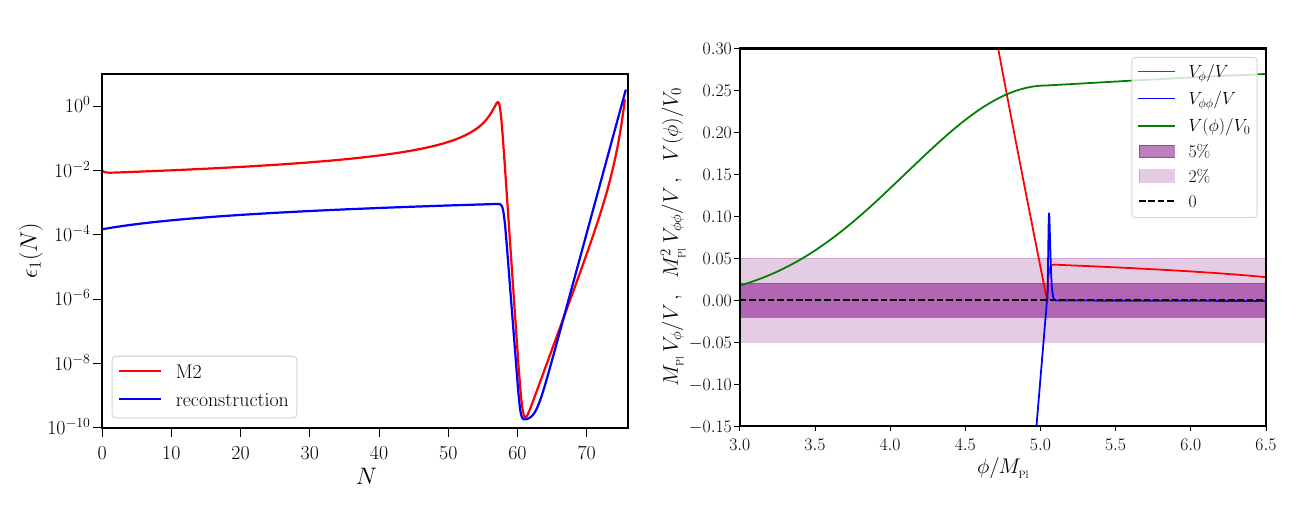
Figure A3. We have presented the behavior of the first slow roll parameter (cid:101) 1 ( N ) as described by Equation (33) (on the left ) and the corresponding potential arrived at numerically, along with its first and second derivatives (on the right ), for a representative set of parameters. The values of the parameters have been chosen to arrive at these behavior are N 1 = 58, N 2 = 75, ∆ N 1 = 0.31 and ∆ N 2 = 0.55. The other related parameters are set to the values mentioned in the main text. We have chosen these parameters to illustrate the manner in which the reconstructed (cid:101) 1 closely mimics the behavior arising in a specific model described by a potential, say, M2 (plotted on the left). It is clear that the reconstructed (cid:101) 1 ( N ) contains all the relevant features of an inflationary model that permits a brief epoch of ultra slow roll. Further, we should note that the value of (cid:101) 1 in the reconstructed scenario over the initial phase of slow roll is much smaller than the value in M2. This leads to a tensor to scalar ratio which is within the observational bound, unlike M2 (cf. Table 1). Note that, in the case of the reconstructed scenario, there exists a point where the first two derivatives of the potential vanish (as illustrated in the figure on the right), implying a point of inflection. This plot has to be compared with the second plot of Figure A1 that illustrates the behavior of the corresponding quantities in model M2, which only contains a near-inflection